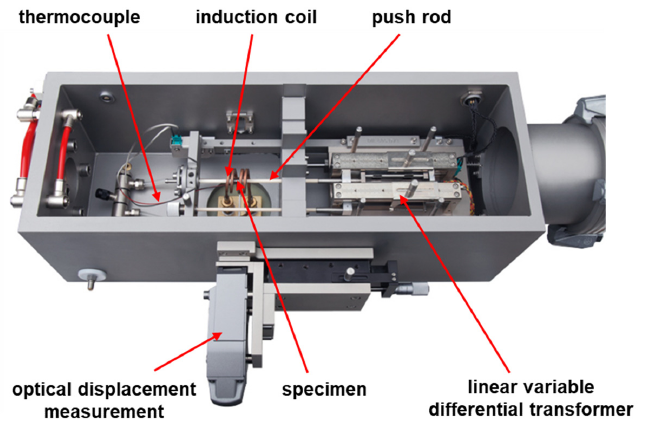
Figure 2. The sample chamber of TA Instruments Dilatometer DIL805.